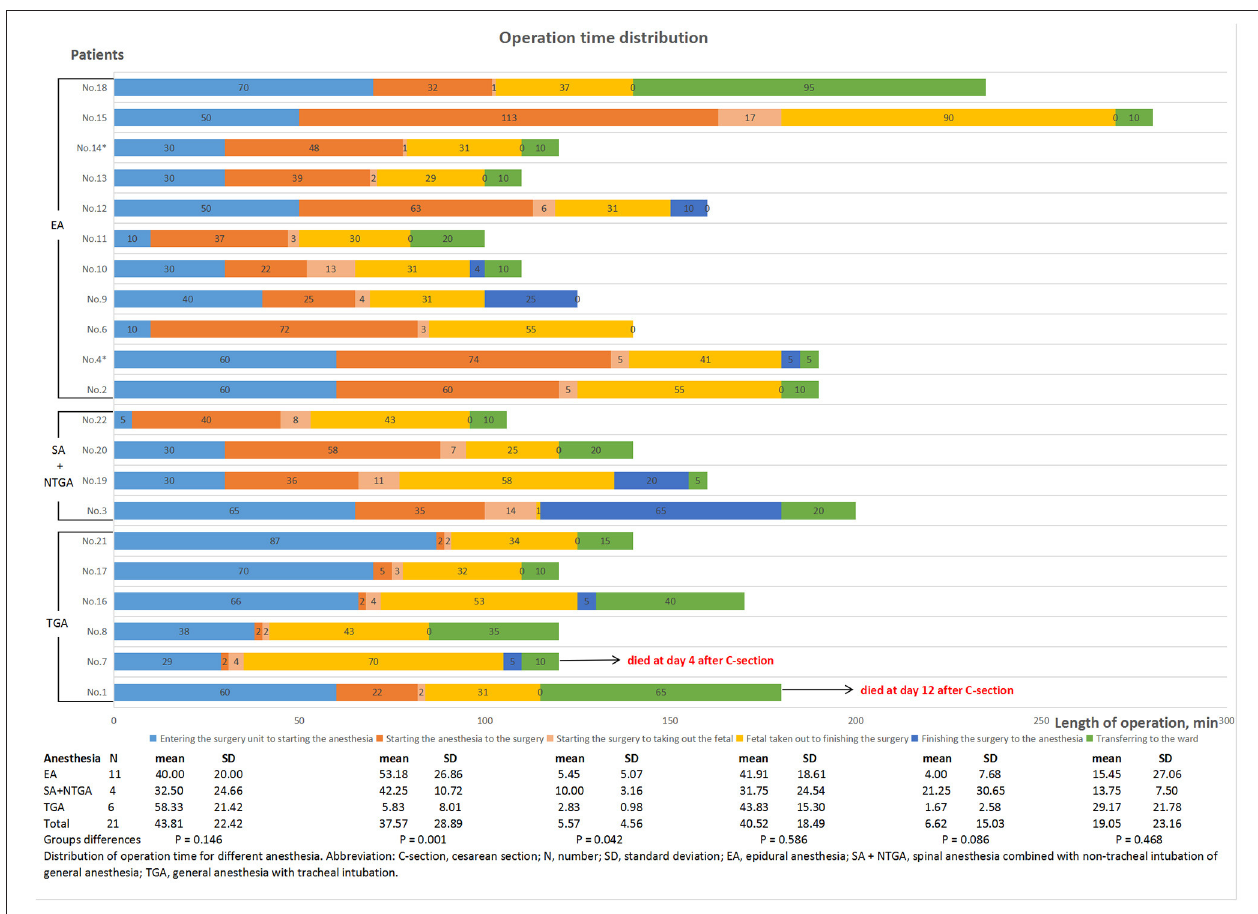
FIGURE 1 | Distribution of operation time for different anesthesia